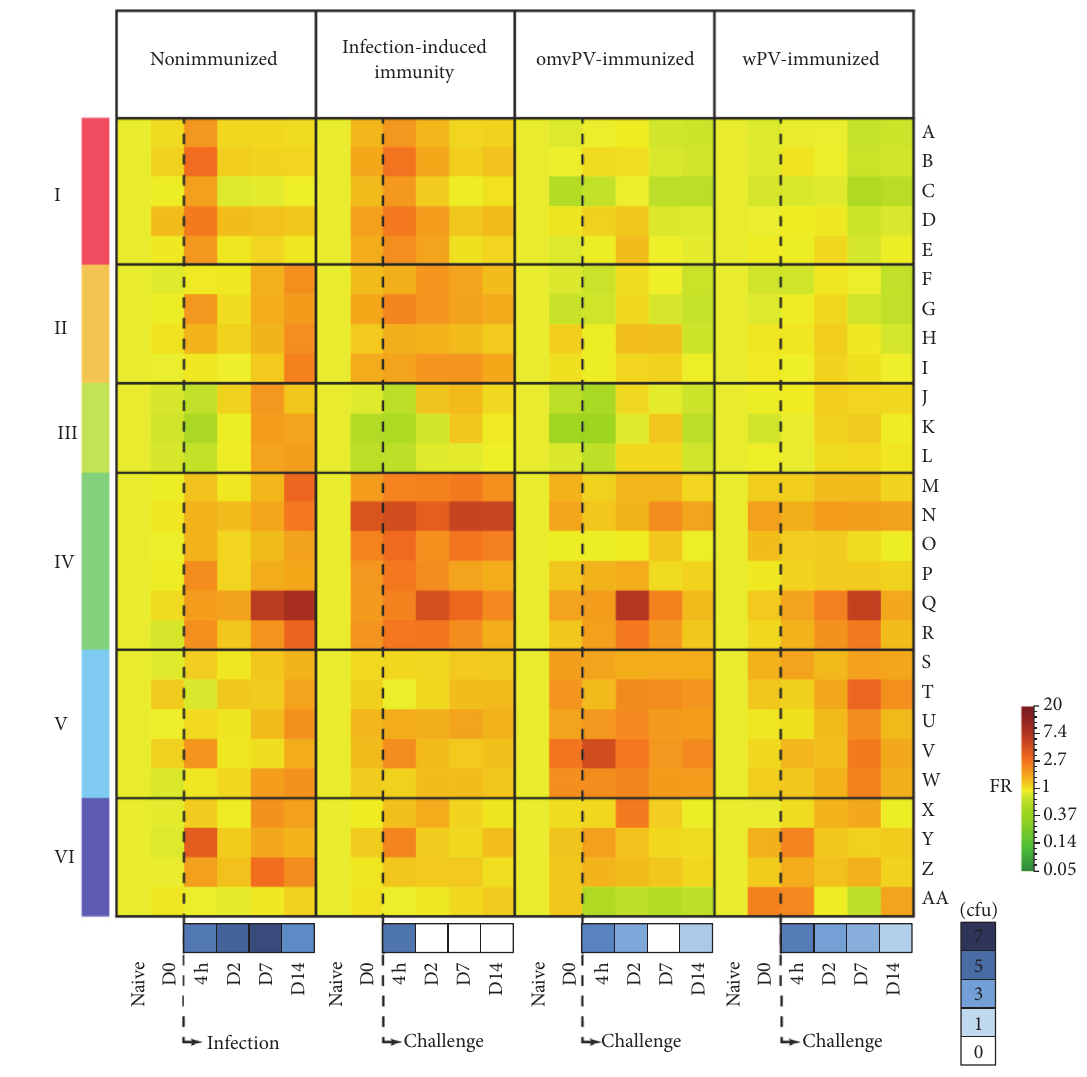
Figure 4: Comparison of pulmonary gene expression profiles following a B. pertussis challenge in mice with different pertussis immunity background. Averaged fold changes of 27 clusters (A–AA) of infected nonimmunized mice and challenged mice with infection-induced immunity, omvPV-immunization, or wPV-immunization background are depicted in a time course. Additionally, six groups (I–VI) with similarity in function are shown. The moment at which the B. pertussis infection or challenge was performed is depicted as well as the log10 number of colony forming units (cfu) for each time point postchallenge as determined previously [7,